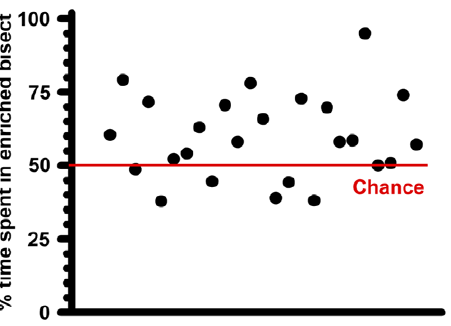
Figure 1. Females prefer enriched males. In a 2-choice preference task, estrous females spent more time in bisect containing inaccessible enriched males and its soiled bedding. Ordinate depicts % time spent in enriched bisect. Each dot in abscissa represents raw data from one female. (relative to total time in control plus enriched bisects). Chi 2 test: p , 0.015,